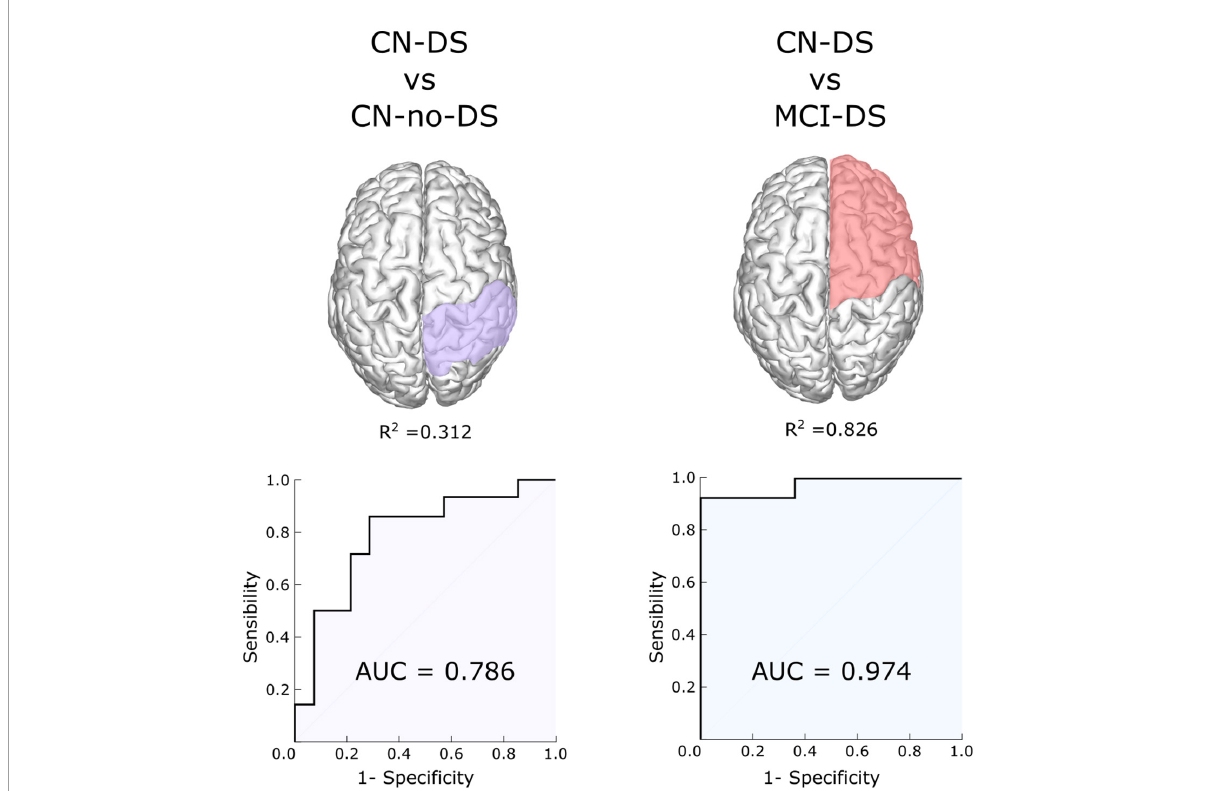
FIGURE3 ROC curves of multivariate logistic regression models including AUC and Nagelkerke coefficient ( R 2 ). R 2 represents that about 31% of the “variability” in the CN-DS vs. CN-no-DS comparison, and about 80% of the variability in the CN-DS vs. MCI-DS comparison is explained by the logistic models. AUC, Area Under the ROC Curve; CN, control; DS, Down syndrome; LZC, Lempel-Ziv complexity; MCI, mild cognitive